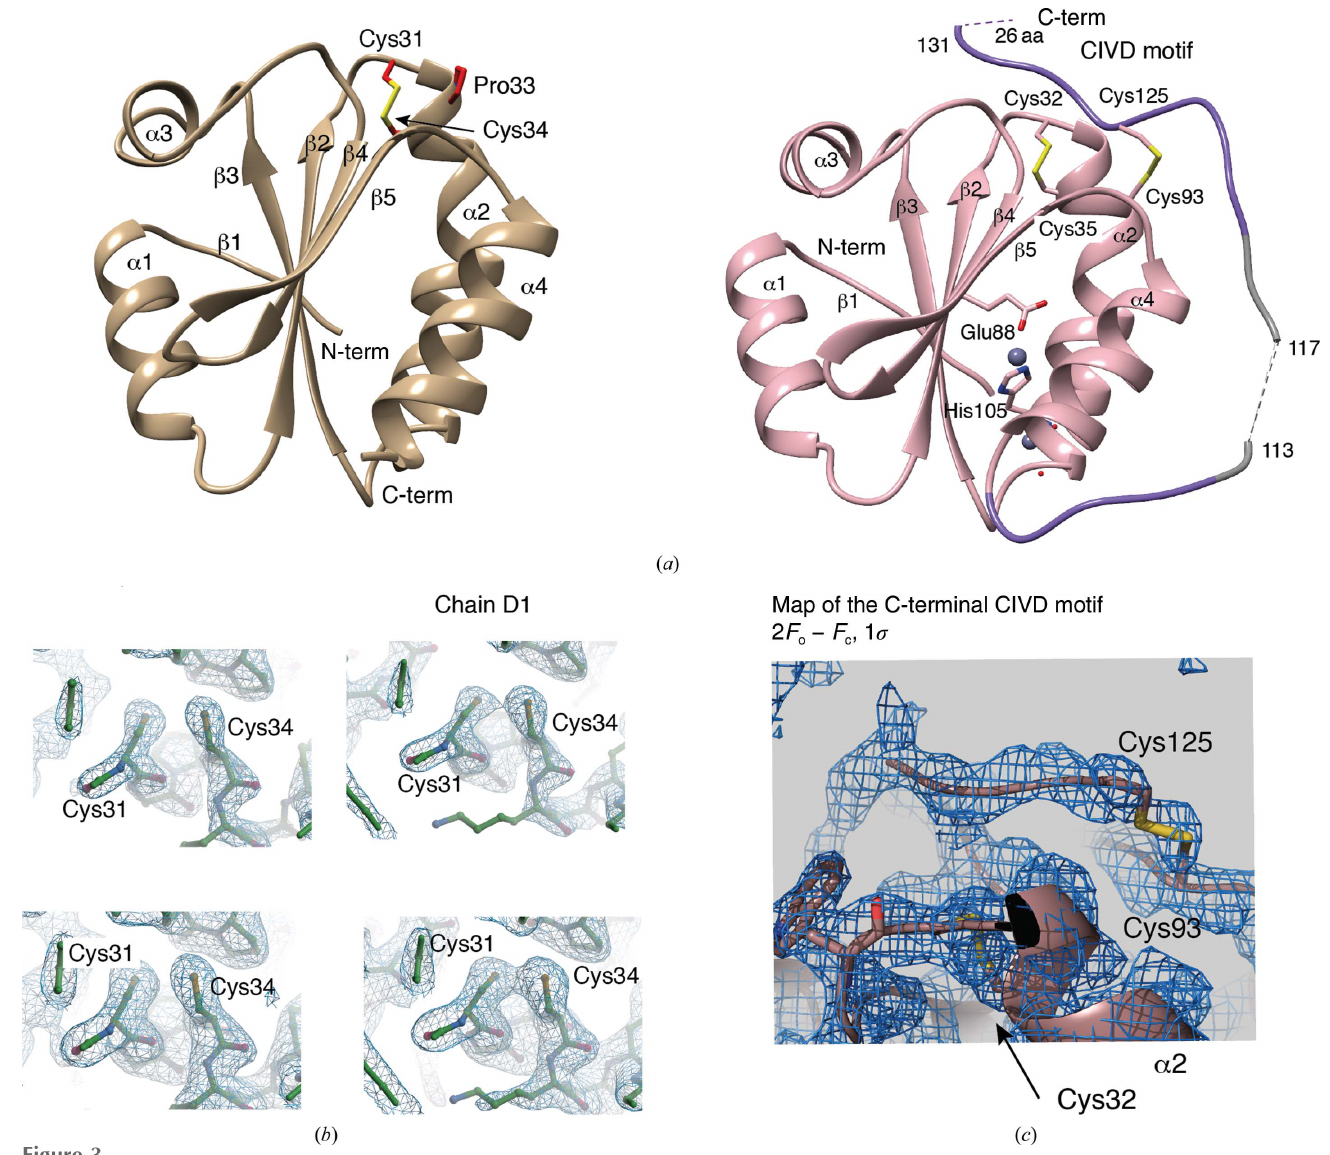
Figure 3 Crystal structures of D. melanogaster Dhd and TrxT. ( a ) Cartoon representation of the crystal structures of Dhd (left) and TrxT (right), showing the oxidized forms. Cys31/Cys32 and Cys34/35 in the catalytic motif are labeled. Secondary-structure elements are also indicated. For TrxT, part of the C-terminal domain was connected to the Trx core domain by a disulfide bridge between Cys93 and Cys125. ( b ) Electron-density map of the Dhd active center including the pair of cysteines Cys31 and Cys34. Left: reduced chain B . Right: partially oxidized chain D . Top: 2 F o (cid:2) Fc electron-density map contoured at 2.0 (cid:7) . Bottom: 2 F o (cid:2) Fc electron-density map contoured at 1.0 (cid:7) . ( c ) The 2 F o (cid:2) Fc electron-density map for the bound C-terminal fragment contoured at 1.0 (cid:7)